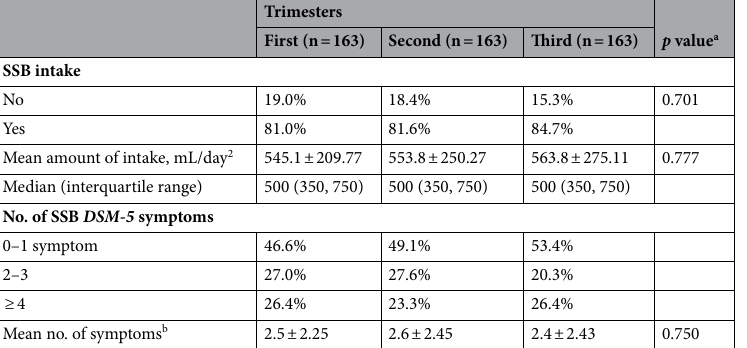
Table 3. Sugar-sweetened beverage (SSB) intake and DSM-5 symptoms in each trimester of pregnancy. a p values for the differences across 3 pregnant trimesters, adjusted for age, educational level, body mass index, nulliparous, and comorbidity in pregnancy. b Data are given in mean ± standard deviation.